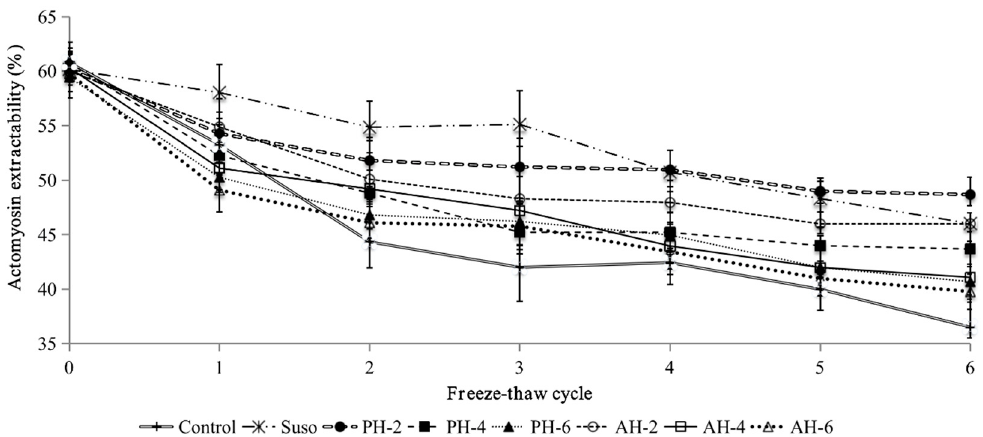
Figure 2. The actomyosin extractability of surimi added with the hydrolysates during freeze-thaw cycles. SuSo (surimi added with sucrose-sorbitol blend); PH-2, PH-4 and PH-6 (surimi with addition of 2, 4, and 6 g of the hydrolysate prepared by Protamex hydrolysis, respectively); AH-2, AH-4 and AH-6 (surimi with addition of 2, 4, and 6 g of the hydrolysate prepared by Alcalase hydrolysis, respectively); and control (surimi without cryoprotectant). The reported data represent mean values from three replications. Bars represent standard